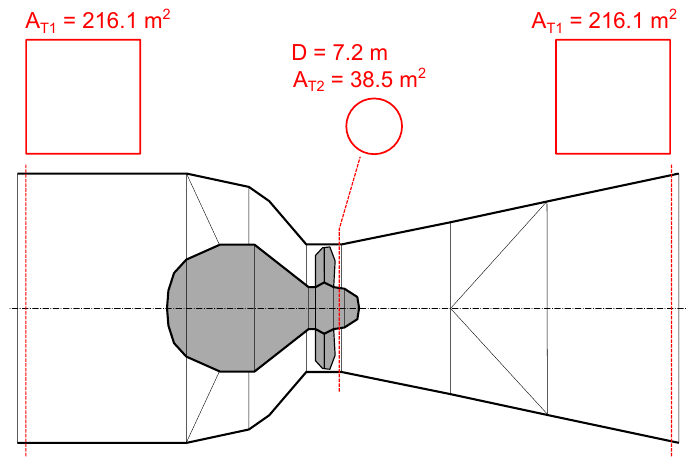
Figure 11. Turbine cross-section - flow through area at the duct entrance and exit is rectangular and it transitions to a smaller circular shape in the middle at the location of the turbine